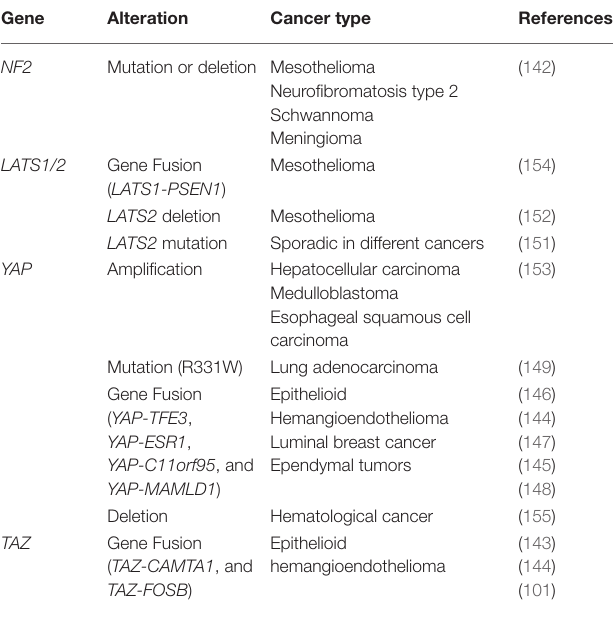
TABLE 2 | Genetic alteration of Hippo pathway in human